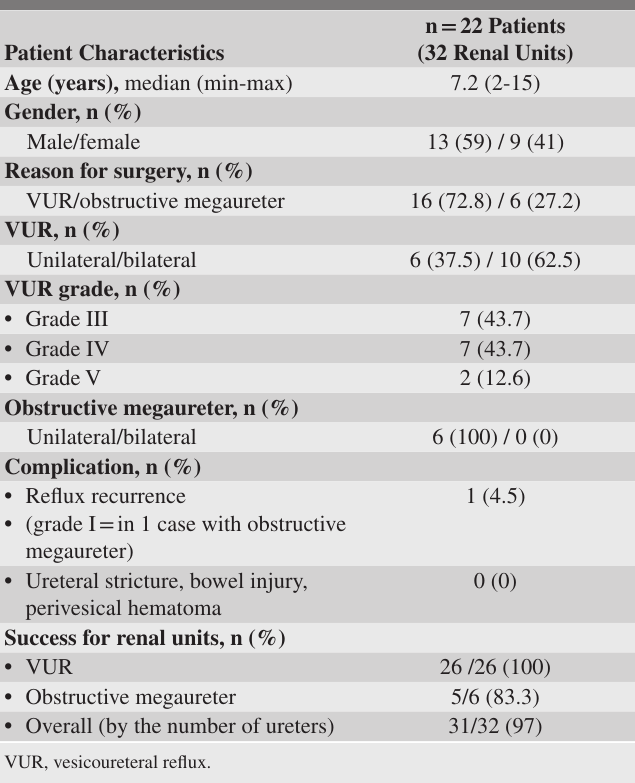
Table 1. Patient